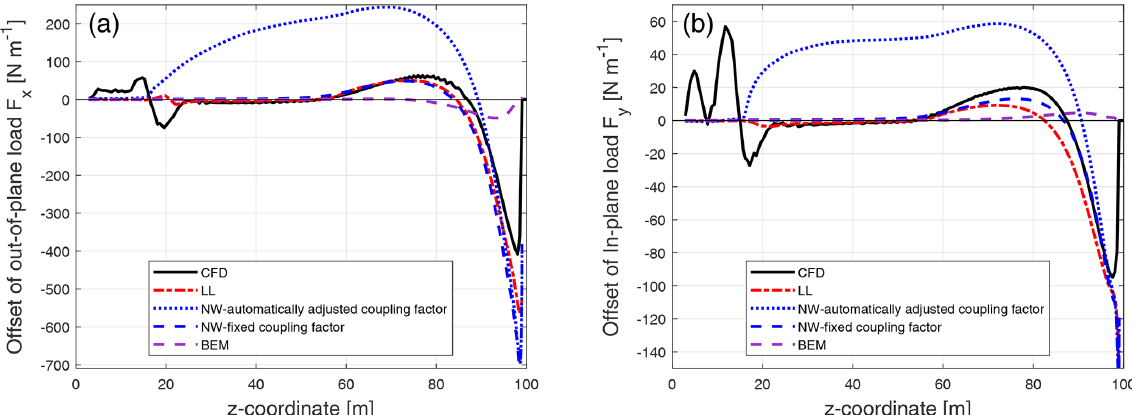
Figure C4. Comparison of the difference between the out-of-plane load (a) and the in-plane load (b) of the forward swept Blade-6 with respect to the baseline blade calculated from the Navier–Stokes solver (CFD), the lifting-line method (LL), the proposed coupled method (NW) and the blade element momentum method (BEM).